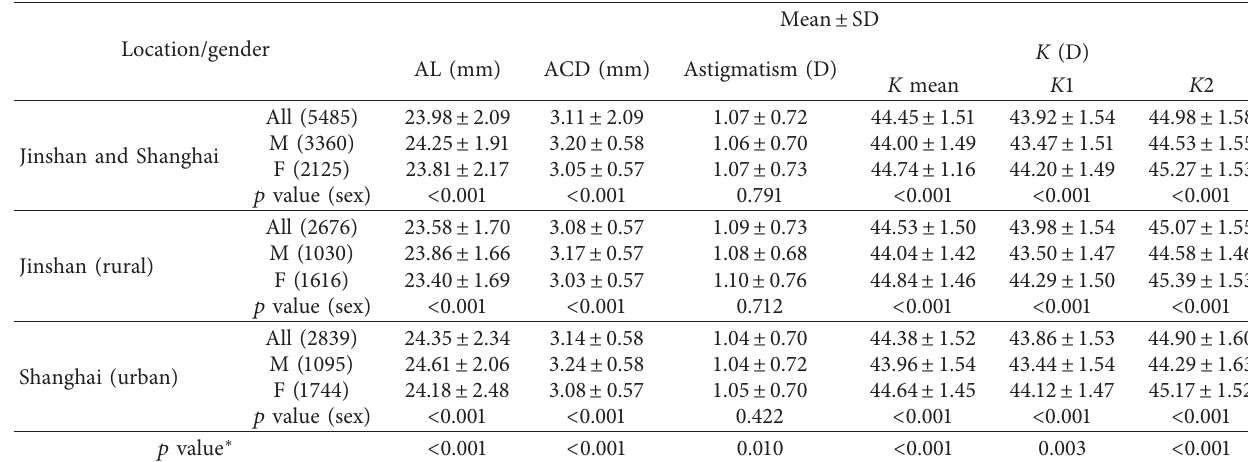
Figure 1: Distribution of axial length in the total Shanghai population. Table 2: Sex distribution of ocular biometric